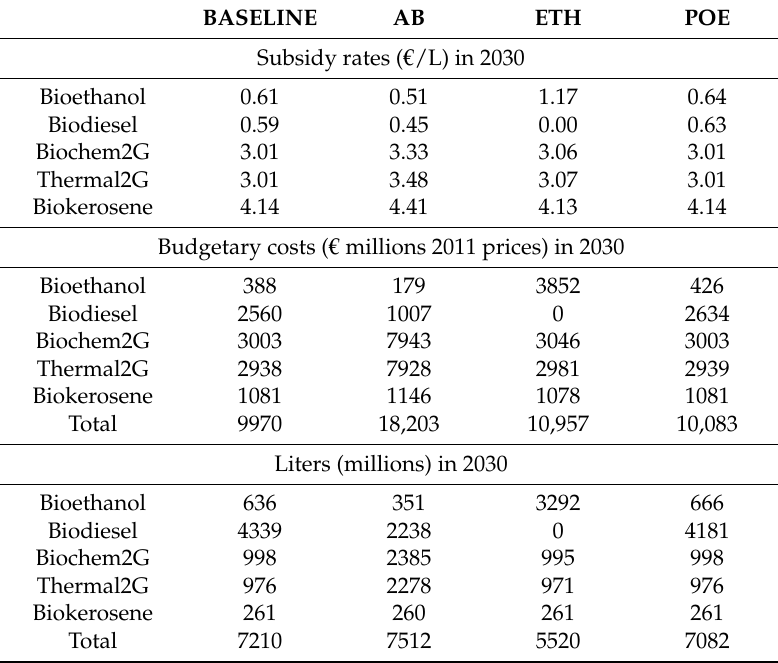
Table 5. Fiscal and quantity impacts of biofuels support